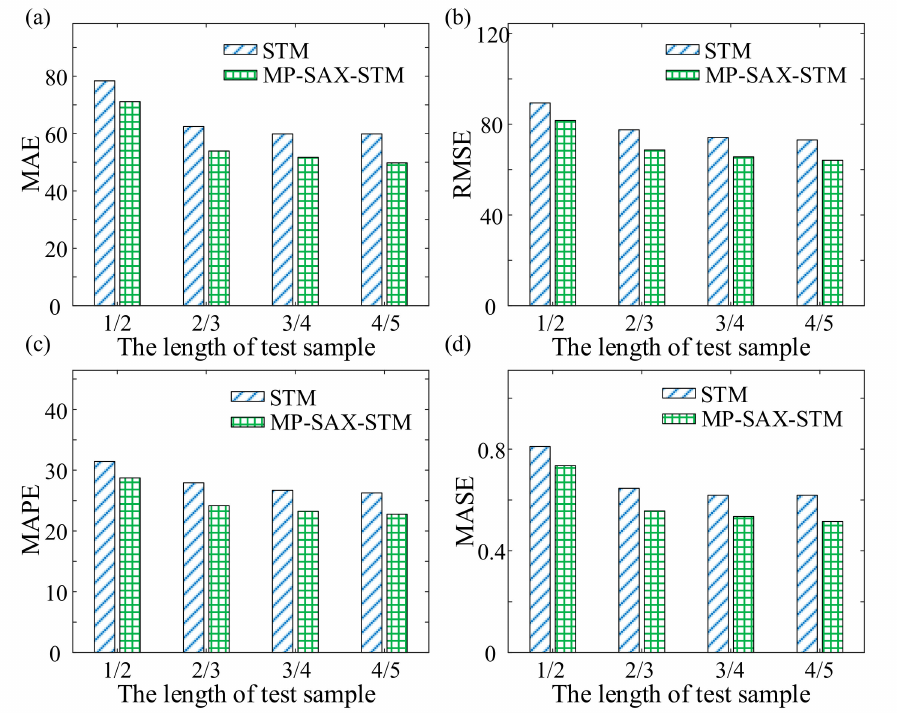
Figure 9. MAE, RMSE, MAPE, and MASE results of Set #4. ( a ) MAE. ( b ) RMSE. ( c ) MAPE. ( d )